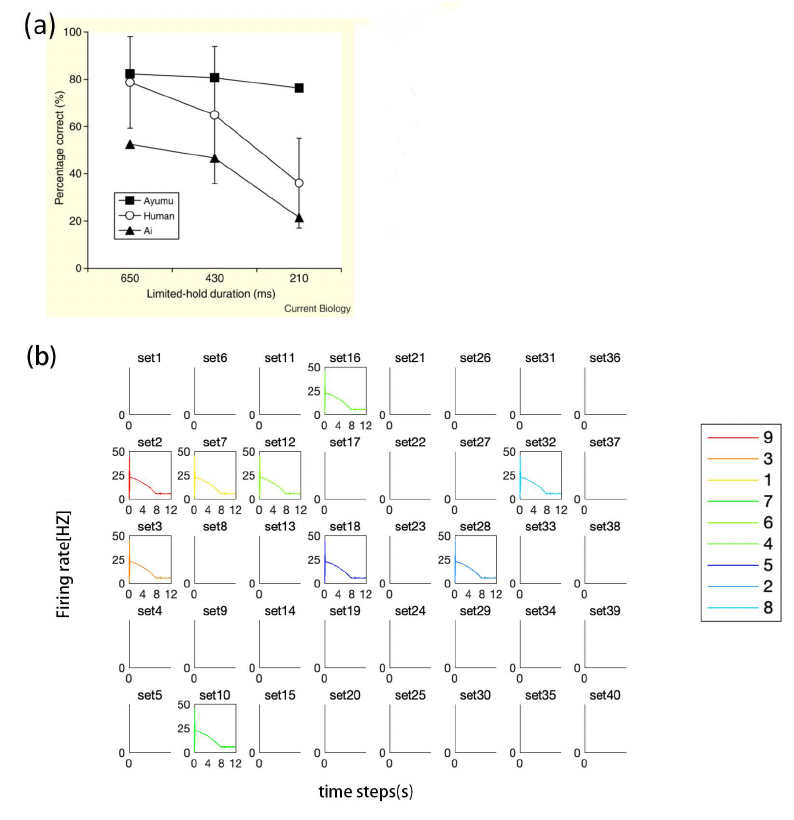
Figure 15. Comparison of SDN and chimpanzees in a limited hold memory task. ( a ) The results of Inoue and Matsuzawa’s chimpanzees in the limited-hold memory task. ( b ) Our model’s simulation during the 210 ms hold